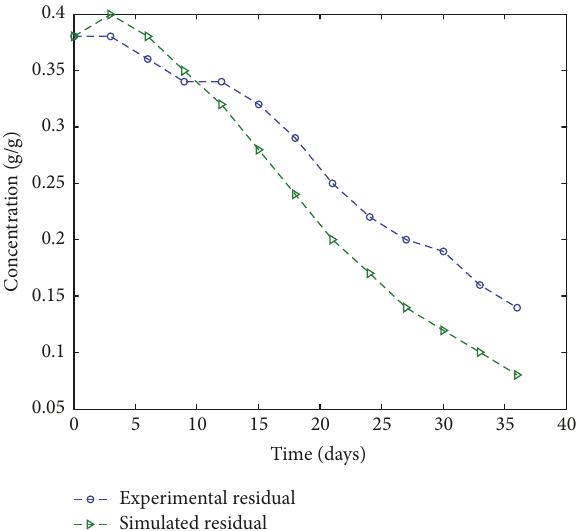
Figure 5: Comparative analysis of experimental and simulated results on soil depth.